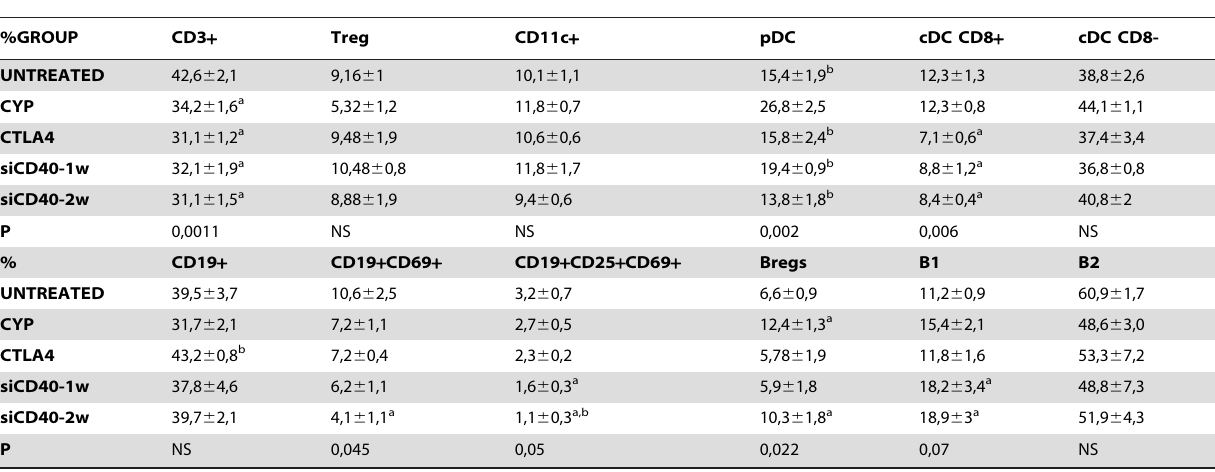
Table 2. Immunomodulation of spleen cell population